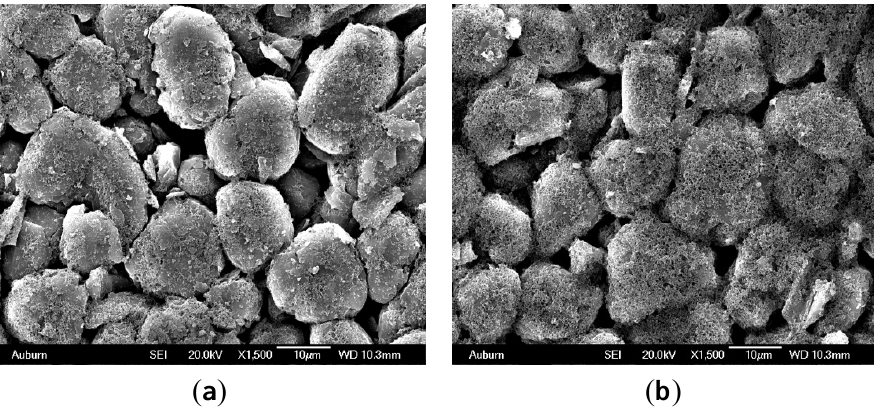
Figure 2. A typical SEM micrograph of surface film growth on the graphite particles.